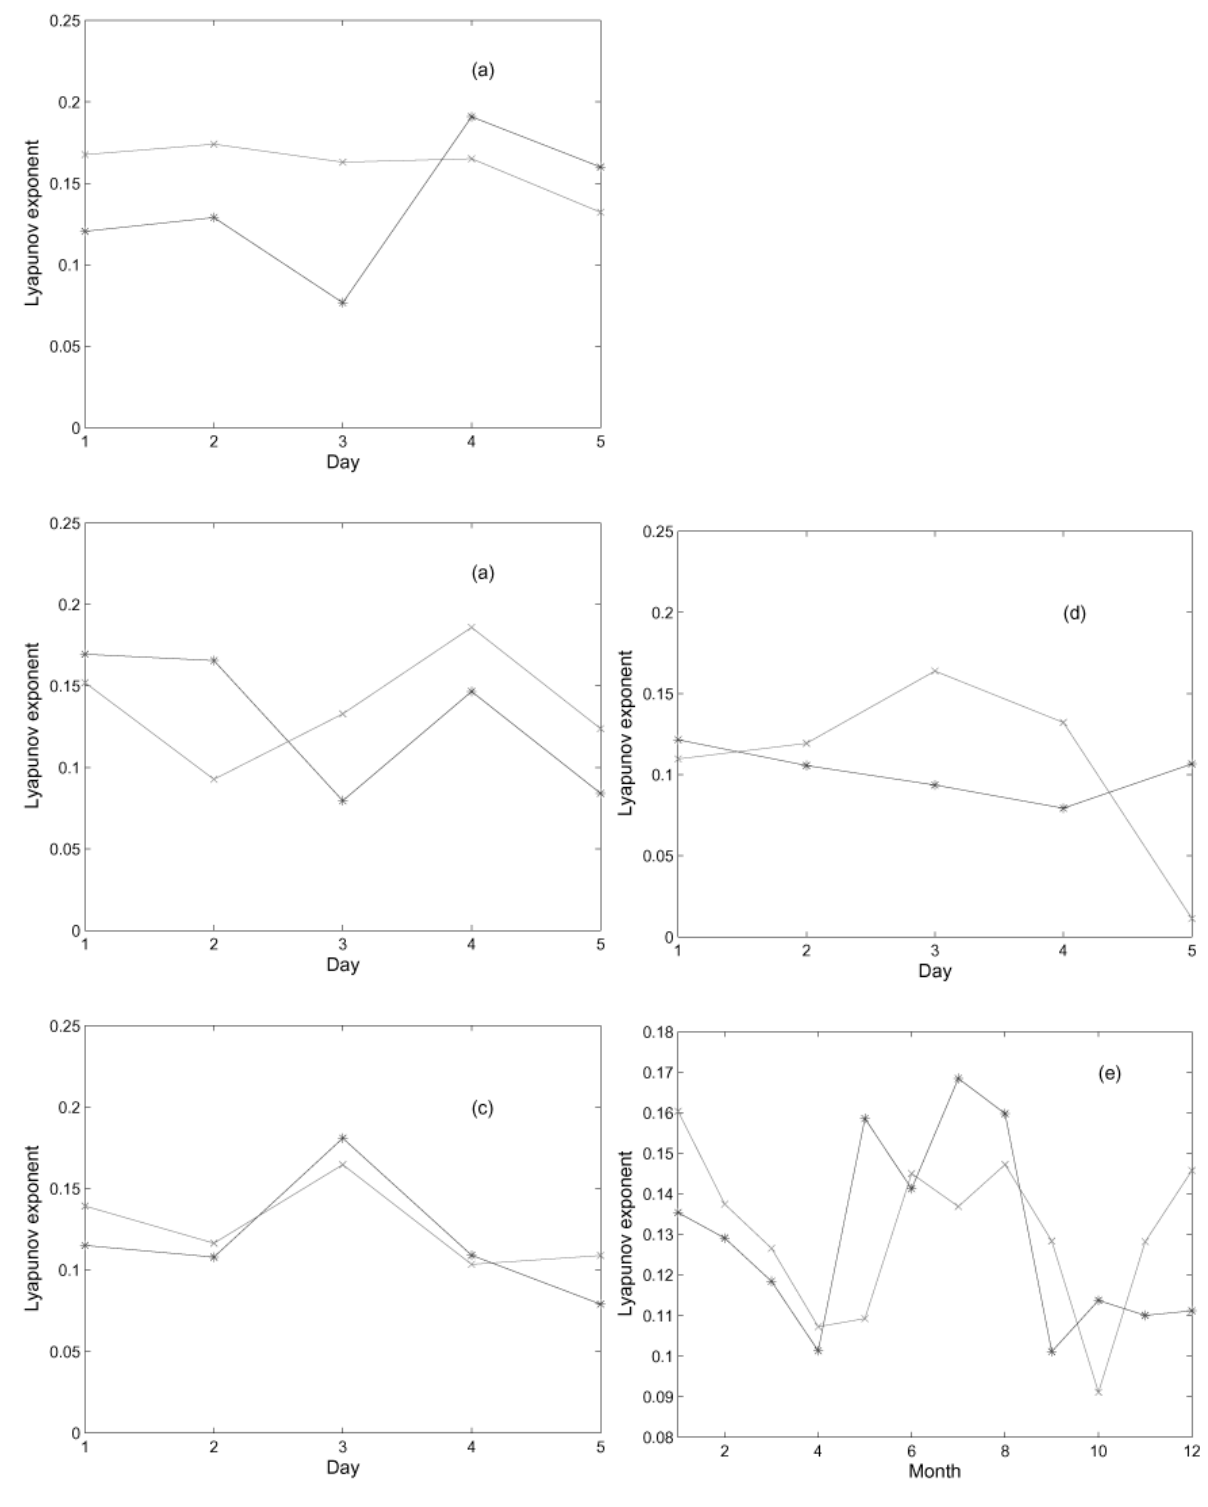
Fig. 8. Lyapunov exponents for the five quietest days (red) and the five most disturbed days (blue) for (a) January, (b) February, (c) March, and (d) April. (e) Monthly mean values of Lyapunov exponents for the entire year at Birnin